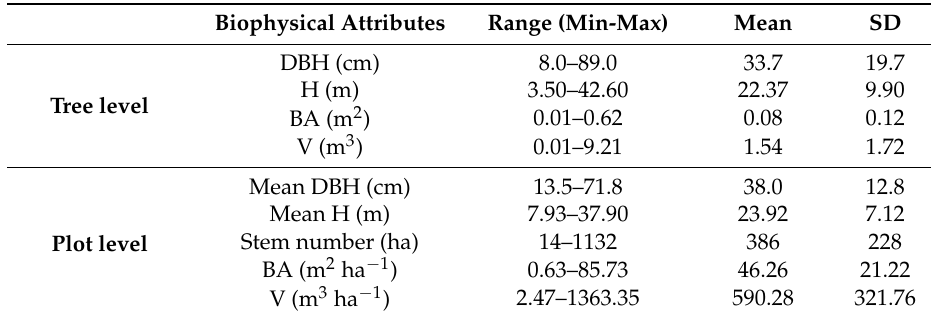
Table 1. Statistics of the field-observed biophysical attributes at the tree and plot level (SD = standard deviation, DBH = diameter at breast height, H = height, BA = basal area, V = volume).